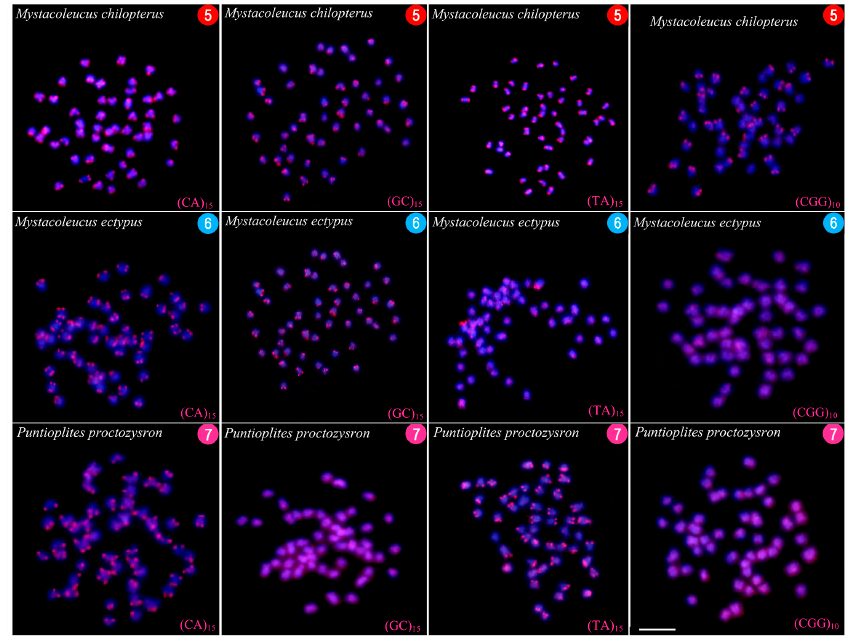
Figure 6. Metaphase plates of Mystacoleucus chilopterus , Mystacoleucus ectypus and Puntioplites proc- tozystron after FISH with different microsatellite motifs. Scale bar = 5 µ